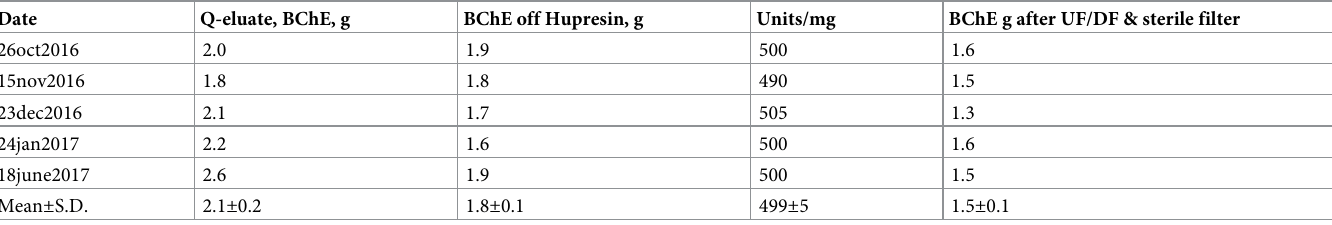
Table 2. Q-eluate a further purified on 4.2 L Hupresin, UF/DF in Pellicon, sterile-filtered.